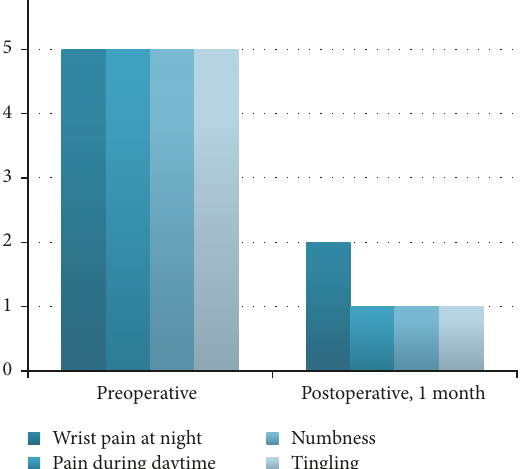
Figure 2: Symptom severity scale (Levine).